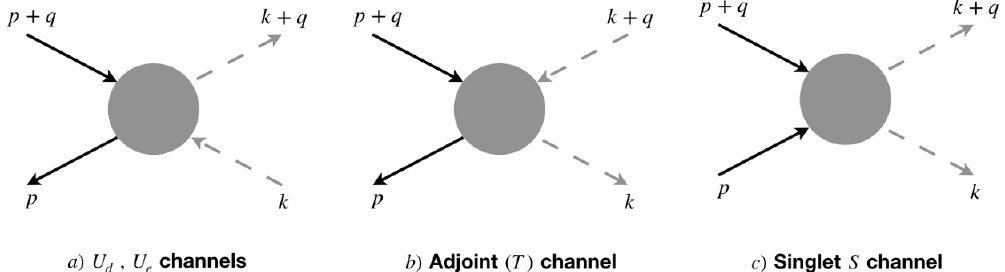
Figure 5 . Various channels of scattering as discussed in section 2.1. The blob indicates the o(cid:11)- shell four point correlator derived in section 5.5.1 and section 5.5.2. The dark continuous and grey striped lines indicate the color (cid:13)ow. The arrow indicates incoming/outgoing quanta. In the (cid:12)gure all the arrows are drawn for positive momenta. For an incoming/outgoing anti-particle the sign of the momentum is opposite to that of the direction of the arrow. Taking the on-shell limit of